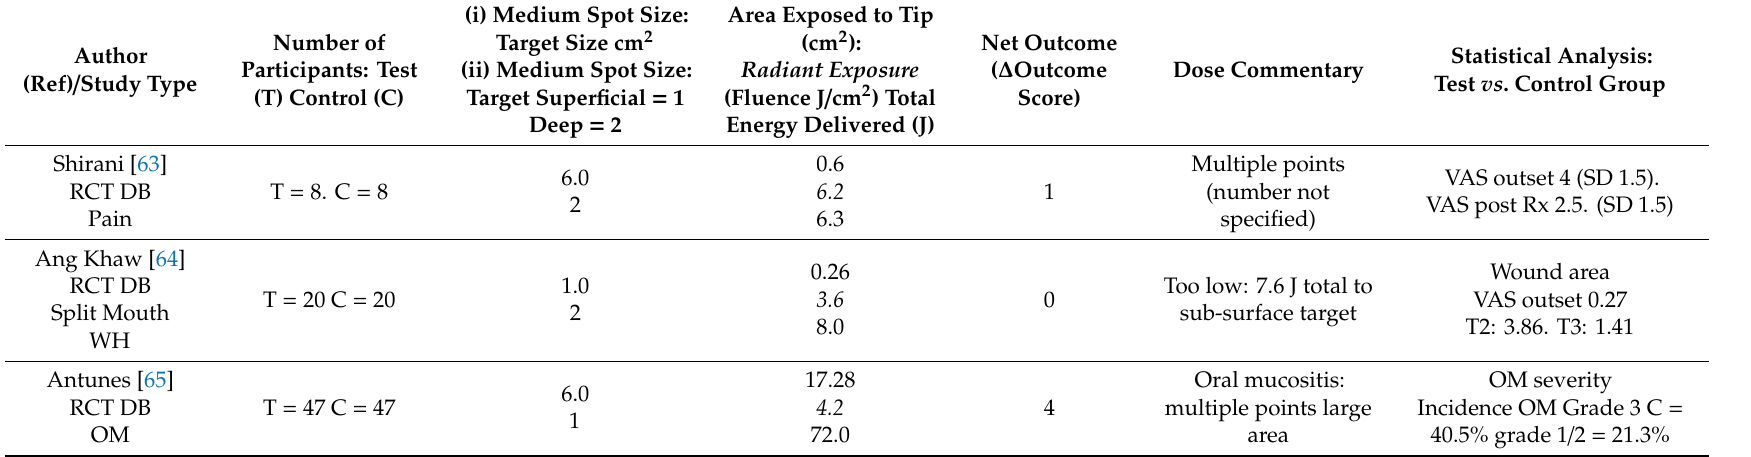
Table 4. Group C. Large spot (0.51 cm 2 –4 cm 2 ) analysis of papers. Outcome key (0–5): Outcome key (0–5): 0 = null e ff ect; 1 = 10–20%; 2 = 20–40%; and 3 =